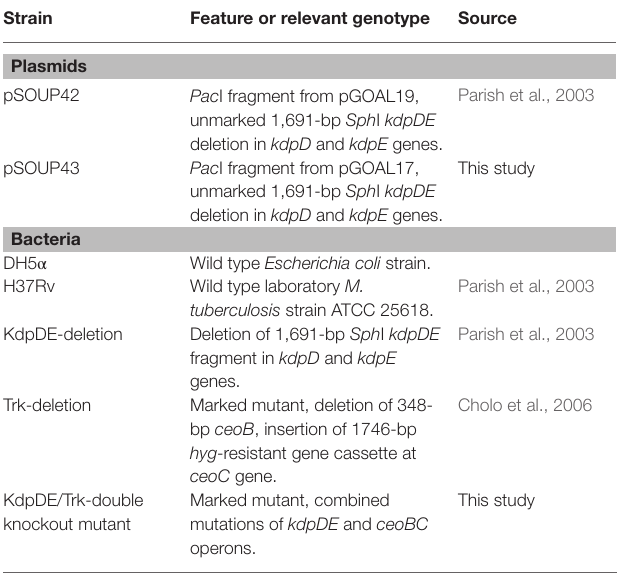
TABLE 1 | Plasmids and bacterial strains used in the